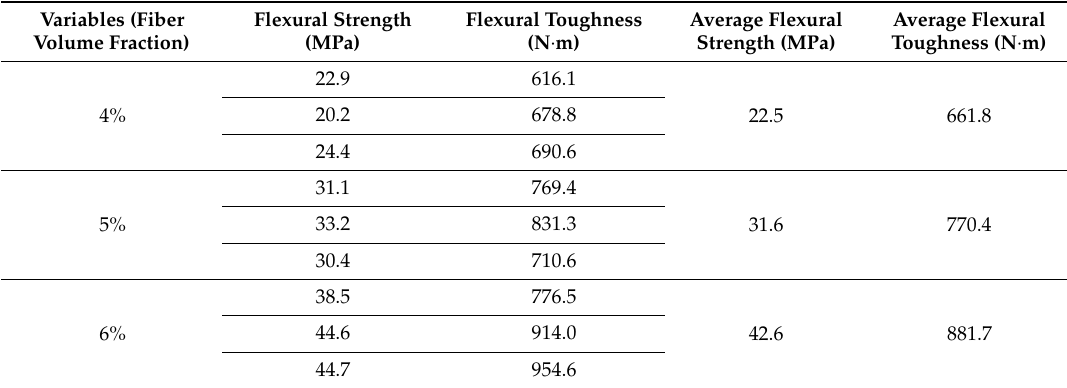
Table 6. Test results of flexural strength and toughness obtained through